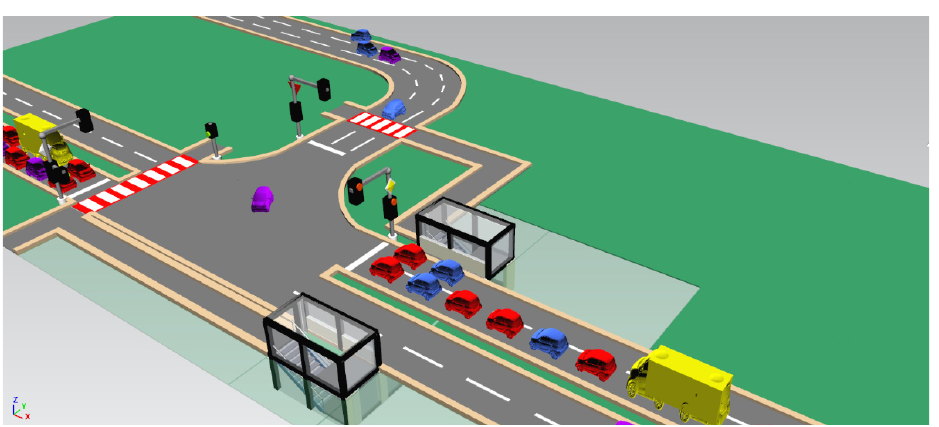
Figure 17. 3D visualization of traffic processes.